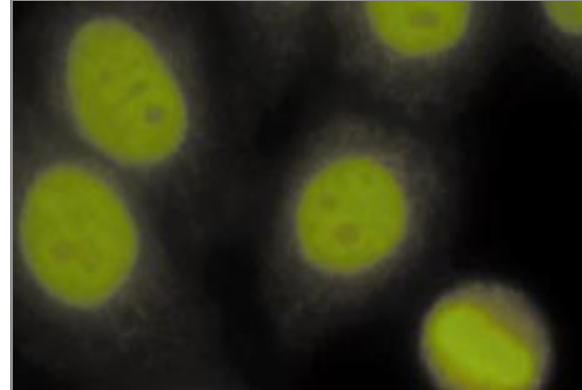
Figura 9 – Nuclear pontilhado fino denso